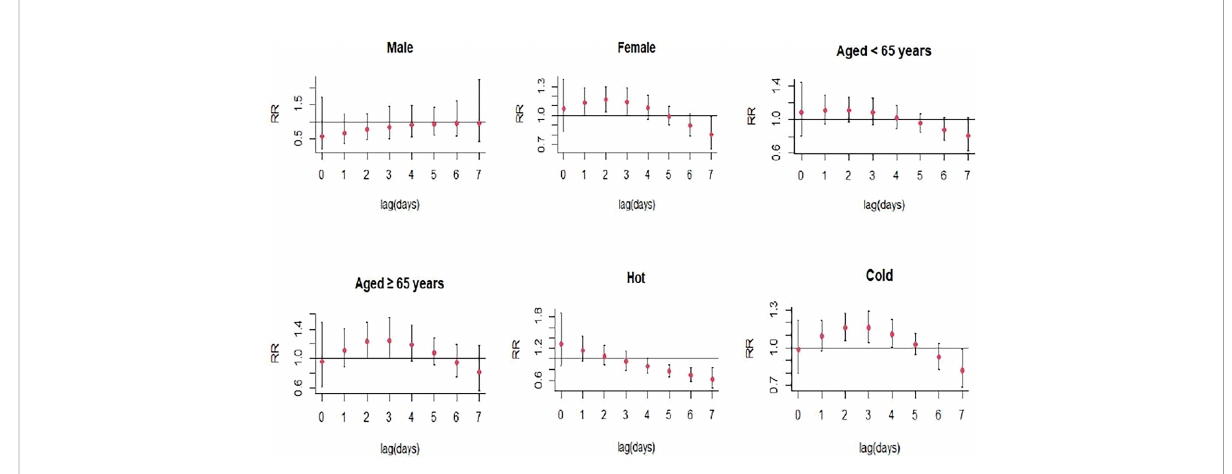
FIGURE 8 Lag-speci fi c relative risks (95% CI ) of SS hospitalizations per 1 unit increase in the daily concentrations of CO in models strati fi ed by age, gender, and